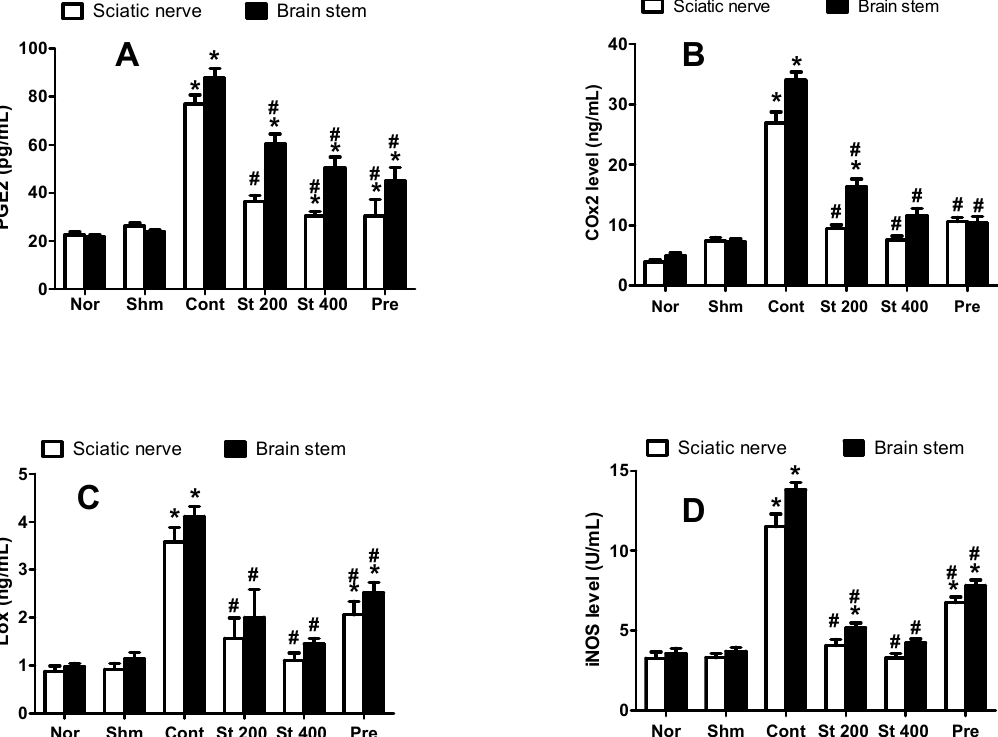
Figure 3. E ff ect of S. tetrasperma extract (200 and 400 mg / kg, p.o.) on CCI-induced rise in PGE2 ( A ), COX-2 ( B ) and 5-LOX ( C ) and iNOS levels in the sciatic nerves and brain stems of CCI rats ( D ). Values are given as mean ± SE, n = 5 rats per group. * p < 0.05, compared to Sham group; # p < 0.05, compared to CCI group. PGE2, prostaglandin E2; COX-2, cyclooxygenase 2; 5-LOX, lipoxygenase, iNOS, inducible nitric oxide synthase. Norm means normal group; Shm means Sham group; St 200 and St 400 mean S. tetrasperma extract (200 and 400 mg / kg) and pre means pregabalin group.